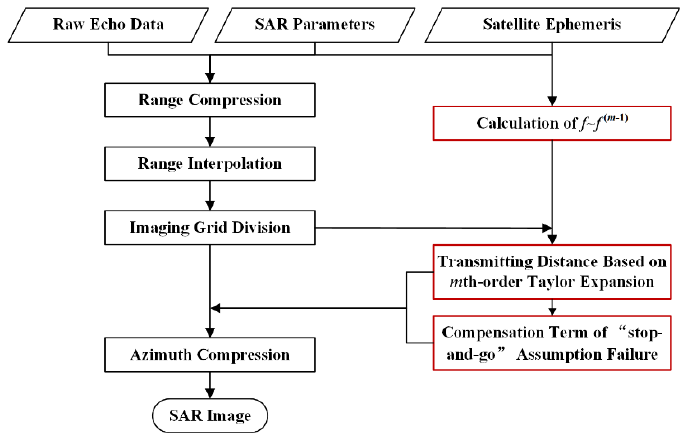
Figure 9. Flowchart of the improved BP algorithm based on the m th-order Taylor expansion range model.